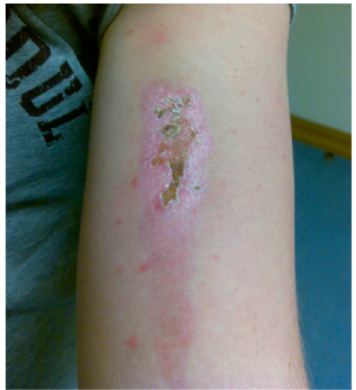
Figure 5. Image displaying the consequences of inadvertent sunlight exposure post-treatment. Patients are advised to follow post-treatment protocols when considering light exposure and other complications. Reprinted with permission from ref. [40]. Copyright 2009 Lasers Surg. Med.